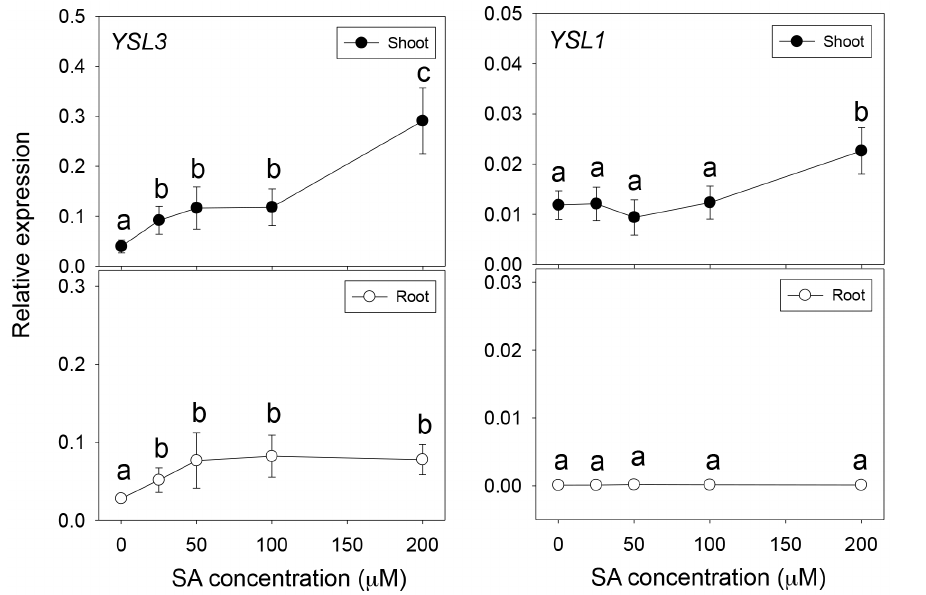
Figure 1. Dose effect of salicylic acid (SA) on the expression of YSL1 and YSL3 in shoots and roots of Arabidopsisthaliana ecotype Col- 0. Twelve-day-old plants were treated with SA (0, 25, 50, 100 and 200 m M) for 24 h. Quantitative real-time RT-PCR (qPCR) analysis of expression of YSL1 and YSL3 in shoots and roots relative to that of ACT2 . Data are mean 6 SD from 9 samples from 3 biological replicates. Different letters indicate significant difference at p , 0.05.